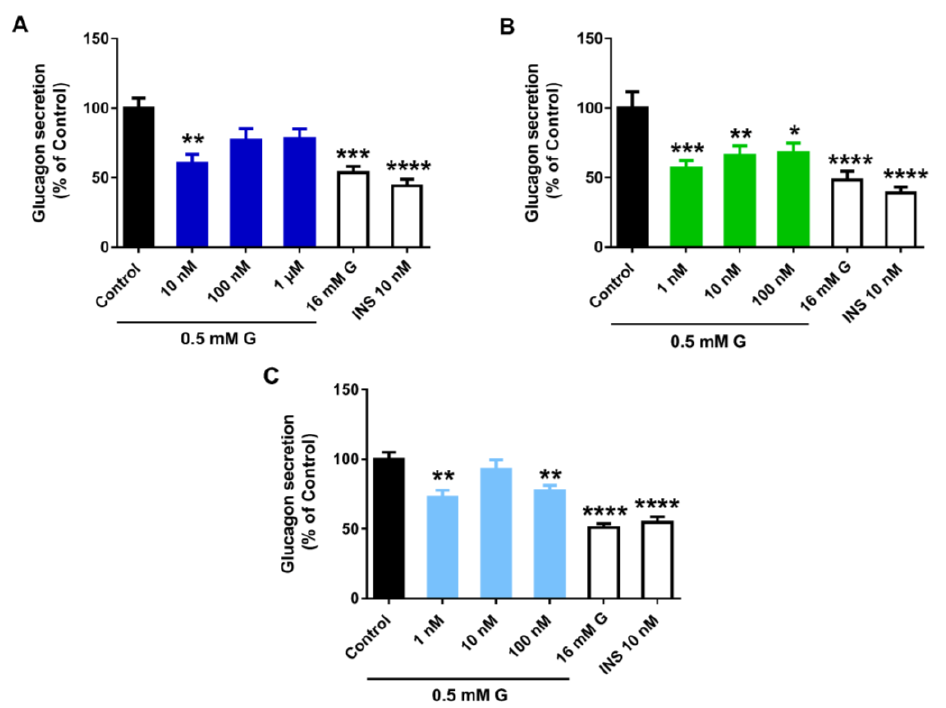
Figure 5. Bisphenols treatment disrupts pancreatic α -cell function. Effects of ( A ) BPA, ( B ) BPS, and ( C ) BPF on glucagon secretion in α TC1-9 cells treated for 24 h. Glucagon release in control- and bisphenol-treated cells was measured in response to 0.5 mM glucose (0.5 mM G). Glucagon secretion in response to 16 mM glucose (16 mM G) and 0.5 mM G plus 10 nM insulin (INS 10 nM) conditions were also included as additional controls. Data are represented as mean ± SEM of ( A ) n = 6, ( B ) n = 6, and ( C ) n = 3 independent experiments. * vs. Control; * p < 0.05, ** p < 0.01, *** p < 0.001, **** p < 0.0001 by one-way ANOVA followed by Dunnett ’ s post hoc test or Kruskal – Wallis followed by Dunn ’ s post hoc test.